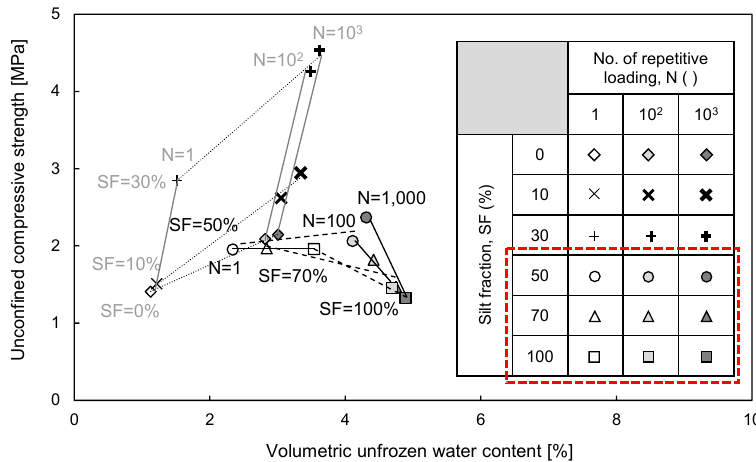
Figure 14. Relationship between unconfined compressive strength and volumetric unfrozen water content of sand–silt mixtures.